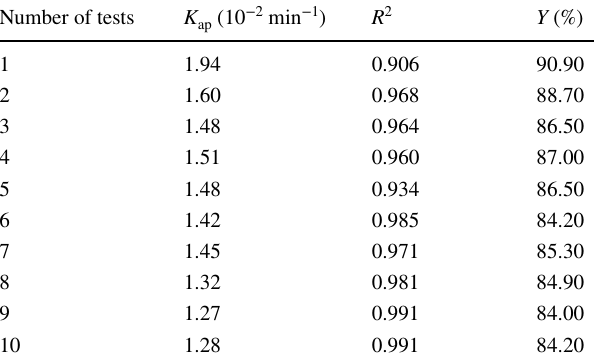
ap ), coefficient of correlation (